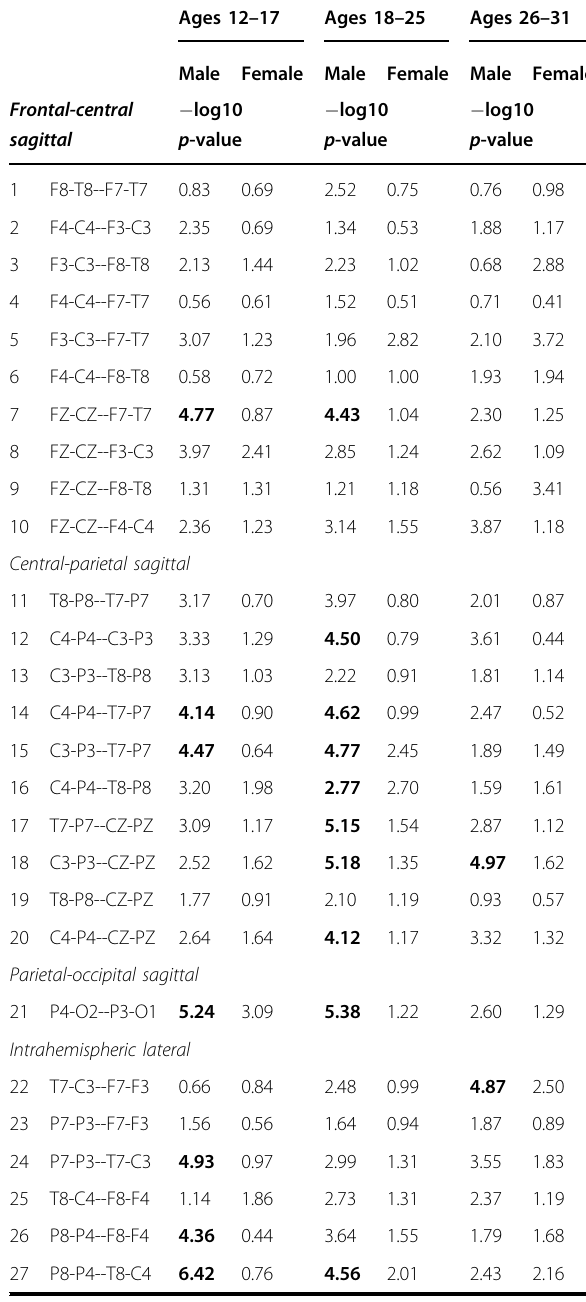
Table 1 First quartile of association beta coef fi cients and p -values of SCZ PRS with high-alpha EEG coherence in males and females ages 12 – 31 with − log10